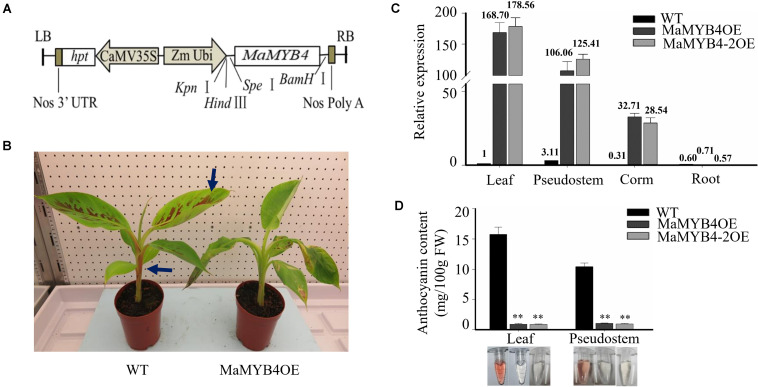
Analysis of MaMYB4 overexpressors. (A) Schematic diagrams of the constructs used for Agrobacterium-mediated transformation. (B) Phenotypic characterizations of wild type and MaMYB4OE following 1.5 months for cultivation in incubator. Expression level of MaMYB4
(C) and anthocyanin content (D) in different tissue of wild type and two MaMYB4 overexpressors. Asterisks on the bar indicate significant difference according to Student t test (P < 0.05). Bar indicates standard deviation (n = 6).